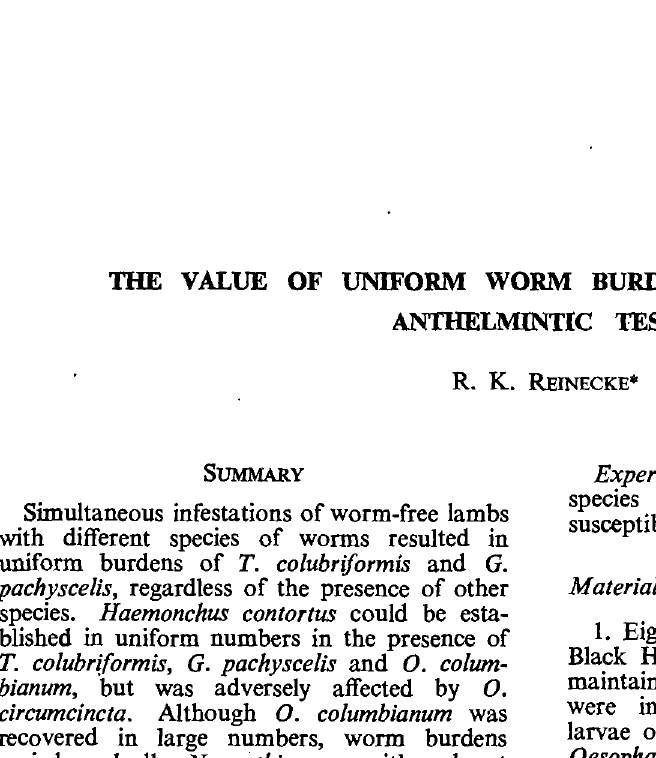
3. The anthelmintics dosed